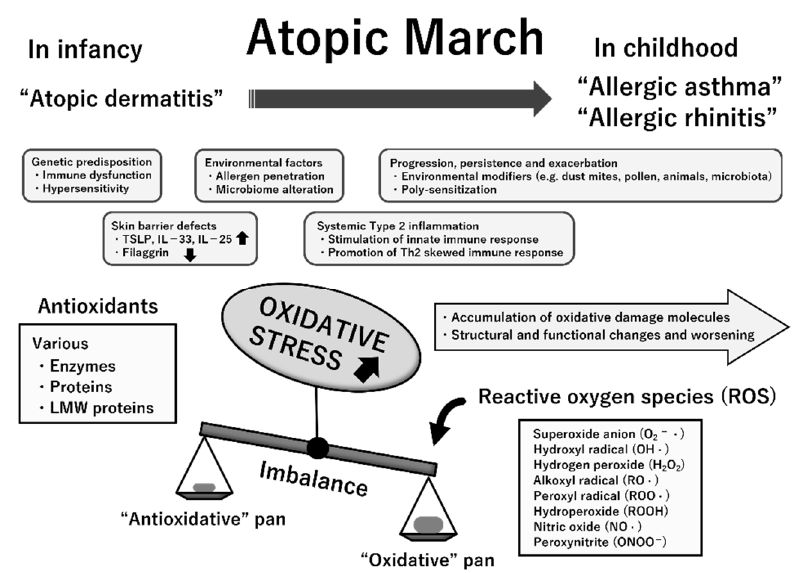
Figure 5. Multifactorial etiopathogenesis and possible involvement of increased oxidative stress status in atopic march. The temporal pattern of atopic march is generally from atopic dermatitis in infancy to gradual development into allergic asthma and allergic rhinitis in childhood. While its pathogenesis is complex, several essential mechanisms likely underlie atopic march. Oxidative stress is an imbalance between reactive oxygen species (ROS) generation and antioxidative defense mechanisms with any excess of the former, resulting in macromolecular damage and dysfunction. Chronically increased oxidative stress may contribute to the progression, persistence, and exacer- bation of allergic inflammation, thereby resulting in atopic march. This suggestion is mostly based on previous clinical studies that have indicated the linkage of oxidative damage attributable to ROS (quantified by measurement of specific biomarkers) to the pathogenesis and progression of these atopic diseases. Abbreviations: TSLP, thymic stromal lymphopoietin; IL, interleukin; LMW, low- molecular-weight.